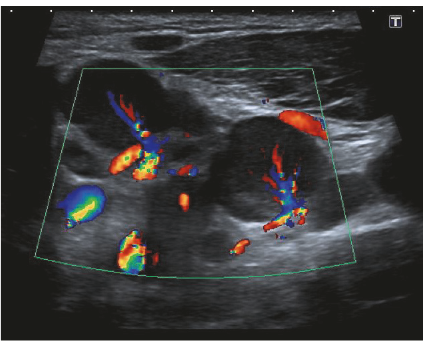
Figure 6: Ultrasound scan showing increased colour Doppler flow through enlarged left cervical lymph